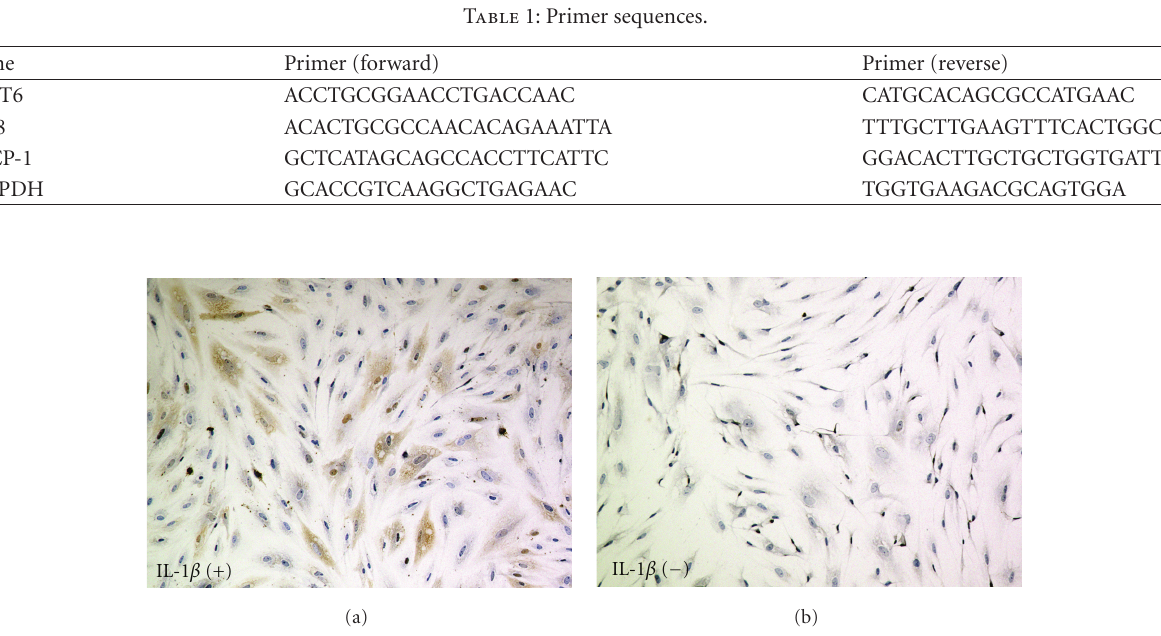
Figure 1: Immunohistochemical analysis of Gb3 expression in HASTs. Immunohistochemistry was performed on HASTs treated with IL-1 β . A condensed brown DAB precipitate was observed in HASTs. A relatively high level of Gb3 was detected in HASTs treated with 10 − 6 mol/L IL-1 β for 48 h (a), compared with the negative control (b) (original magnification × 100).